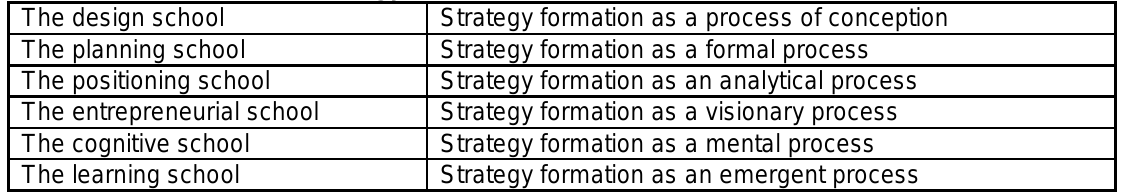
Table 1: Ten schools of strategy